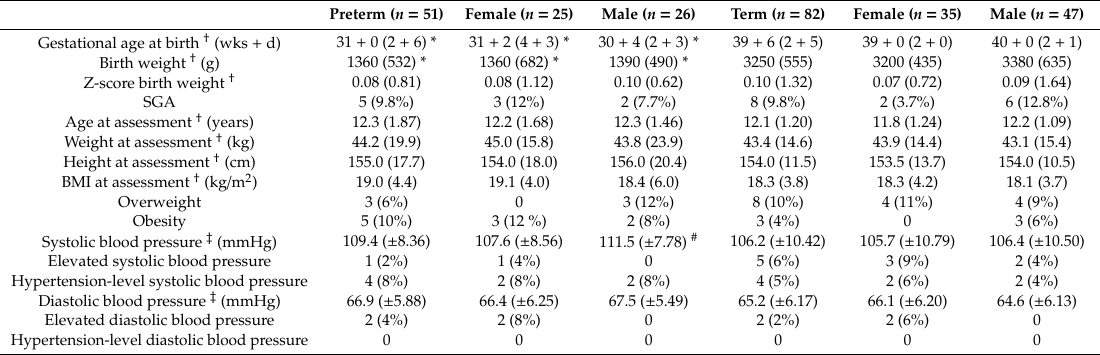
Table 1. Characteristics of former preterm-born study participants and term-born control study participants, as complete groups and by sex.